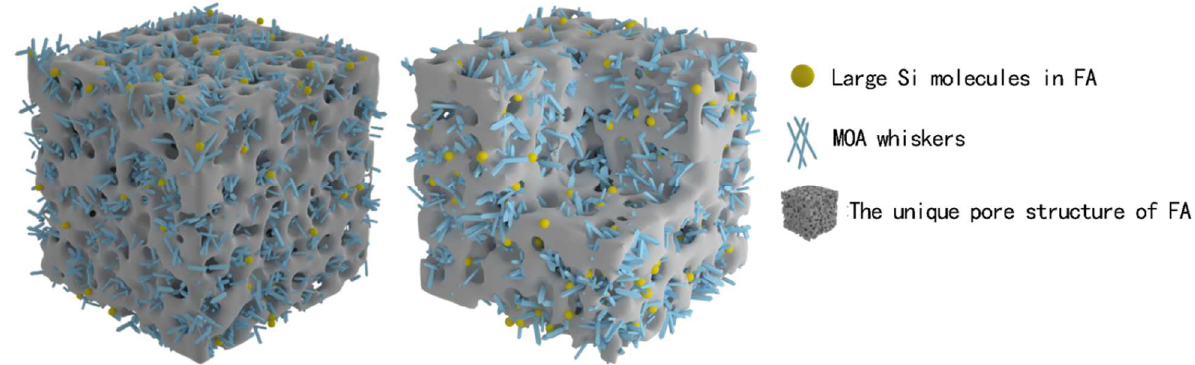
Figure 8. The model of MOPB-FA.